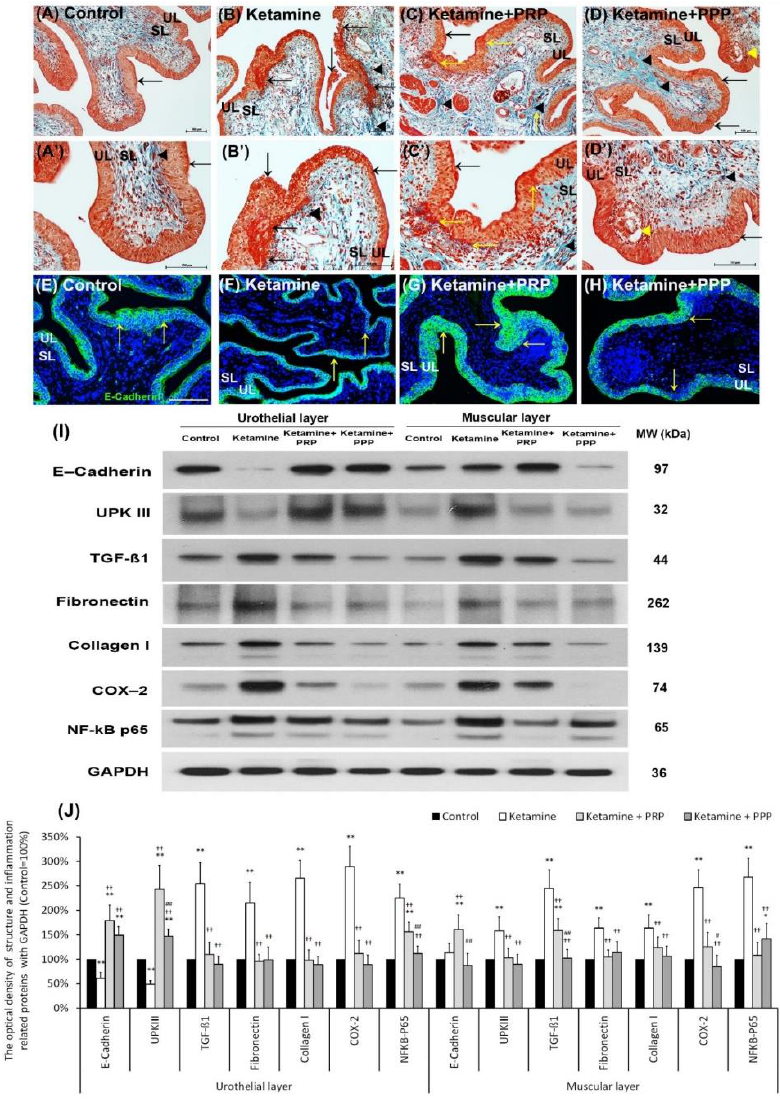
Figure 2. Therapeutic effect of PRP improved ketamine-induced pathological alteration by Masson’s trichrome staining, immunofluorescence and western blotting analysis. ( A – D ’) Bladder pathological features of the control group ( A , A’ ), the ketamine group ( B , B’ ), the ketamine + PRP group ( C , C’ ) and the ketamine + PPP group ( D , D’ ). Masson’s trichrome stain showed red-stained smooth muscle, navy blue-stained nucleus, green-stained collagen. In the control group ( A , A’ ), there were three to five layers of the urothelial layer (UL) and only scattered collagen (yellow arrow) distributed in the suburothelial layer (SL; lamina propria). In the ketamine group ( B , B’ ), the morphology was characterized by thinner layer of urothelial cells, hemorrhage (Black arrows), much collagen accumulation (Black arrowheads) and increased bladder fibrosis (yellow arrows). In contrast, the pathological features of the ketamine + PRP group ( C , C’ ) and the ketamine + PPP group ( D , D’ ) showed recovered ketamine-induced bladder damages by increasing thicker layer of urothelium (Black arrows) and reducing interstitial fibrosis (Black arrowheads) when comparing to the ketamine group. Especially, there was a vacuolation beneath urothelial layer (Yellow arrowhead) in the ketamine + PPP group. ( E – H ) The expression of cell-adhesion protein E-cadherin by immunostaining was shown. In the control group ( E ), the E-cadherin staining was found in urothelial intercellular junctions. In contrast, there was less E-cadherin staining distribution in thin urothelium of the ketamine group ( F ), but the immunostaining of the ketamine+ PRP group ( G ) and the ketamine+ PPP group ( H ) were enhanced in urothelium. ( I , J ) Western blotting analysis was performed to